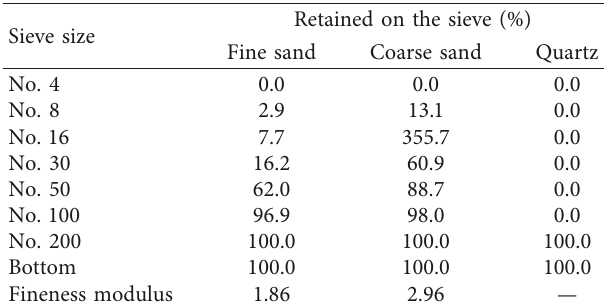
Table 3: Sand and quartz gradation. Retained on the sieve Sieve size